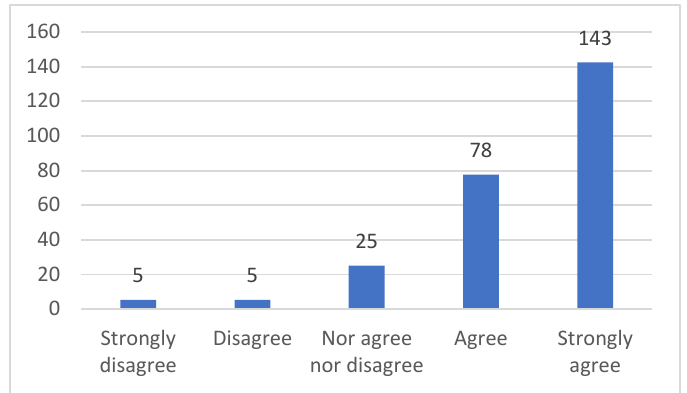
Figure 11. Answers to question 2: The assessment of engineering contents is positive.